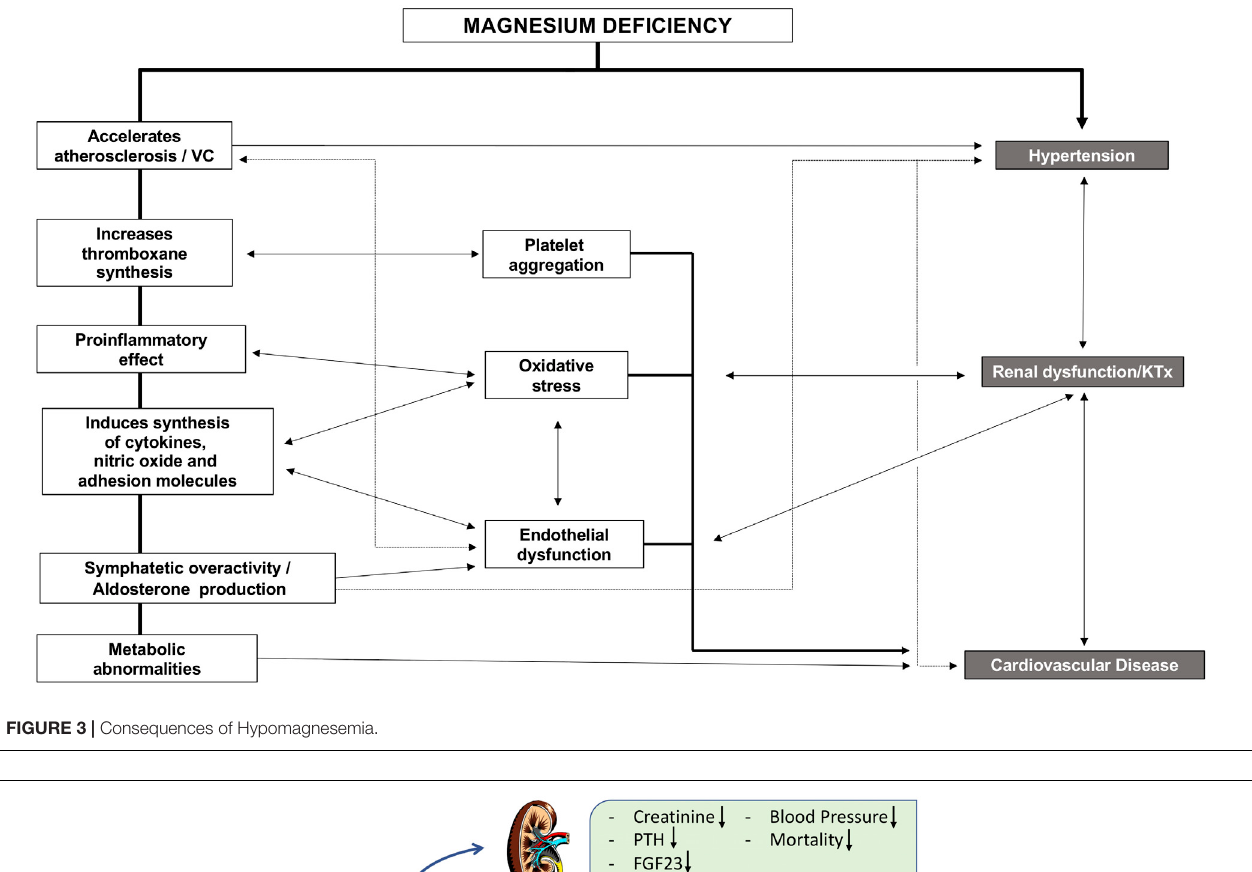
FIGURE 3 | Consequences of Hypomagnesemia.